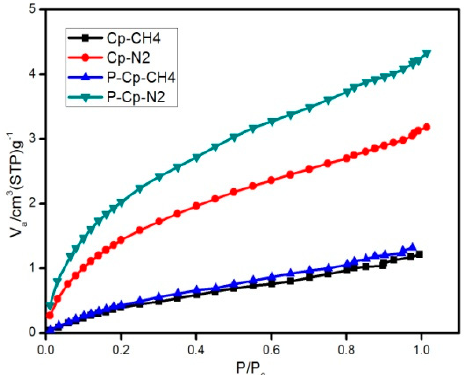
Figure 4. Low-pressure nitrogen and methane isotherms on raw and purified Cp at 298 K.